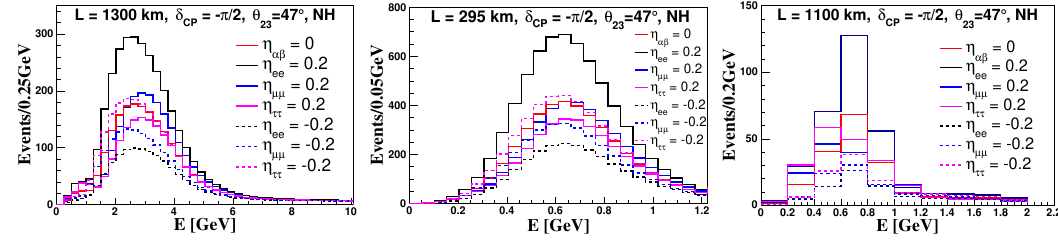
at corresponding peak energies. Here, θ = 47 ◦ and true αβ 23 . αβ